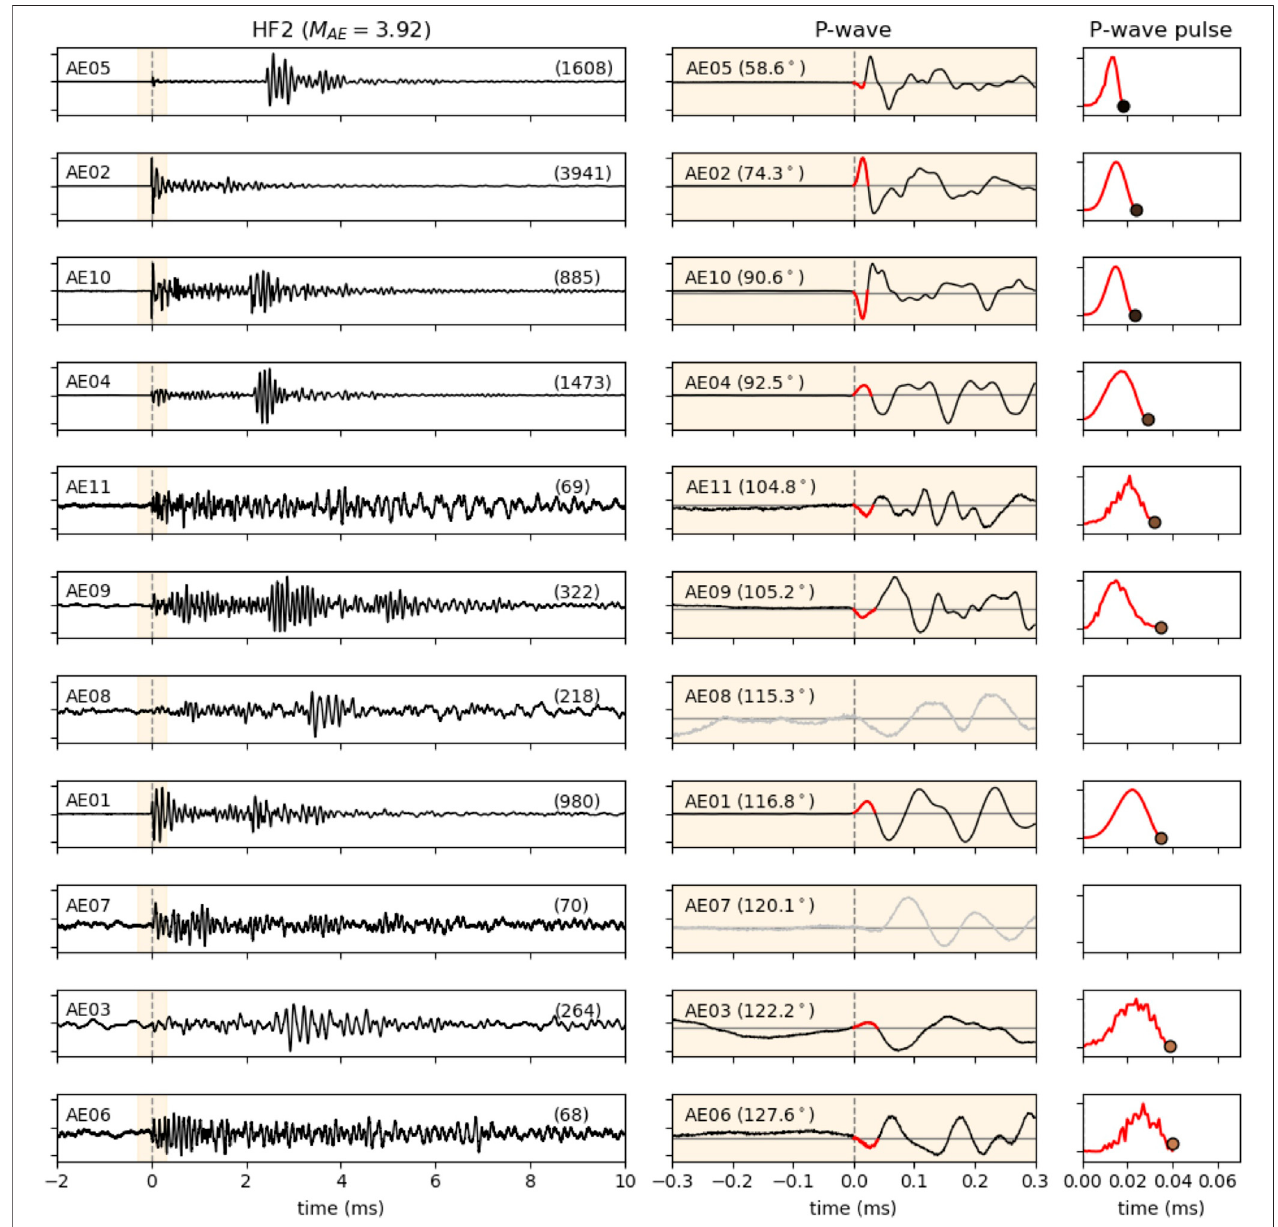
FIGURE 2 | Apparent durations for the largest AE event recorded during HF2 in the Äspö HRL. We plot the un fi ltered waveforms (black lines), P-wave window (orangeband),the fi rstP-wavepulses(redlines)andtheapparentdurations(dotsaccordingtothecolorbar in Figure3A ).Manualpickingandthebaselineareindicated inthesecondcolumnwithverticaldashedgraylinesandhorizontalgraylinesrespectively.Waveformsarenormalizedaccordingtothemaximumamplitude(seelabelsin each trace ofthe fi rst column)and sorted bythe parameter κ (see labels ofthe second column).Some AEsignals are discarded from the rupture directivity analysis because the fi rst P-wave pulse is not well constrained and does not allow a clear estimate of the apparent durations (grey traces in second column for AE07 and AE08). The third column shows the normalized square amplitude of the P-wave pulse shown in the second column to improve the visualization of the apparent duration measurements.